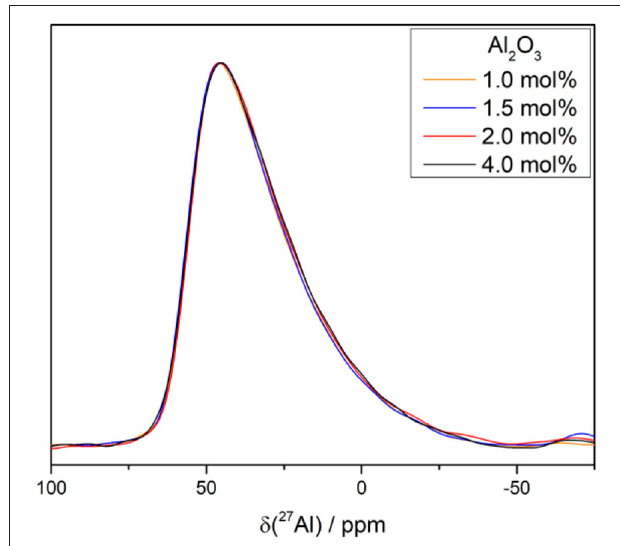
FIGURE 2 | 27 Al MAS-NMR spectra of the furnace cooled NBS2-Glasses at 300